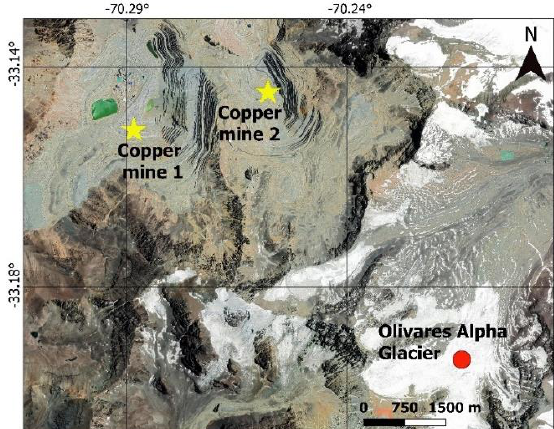
Figure 2. Location of Copper mining sites next to Olivares Alpha